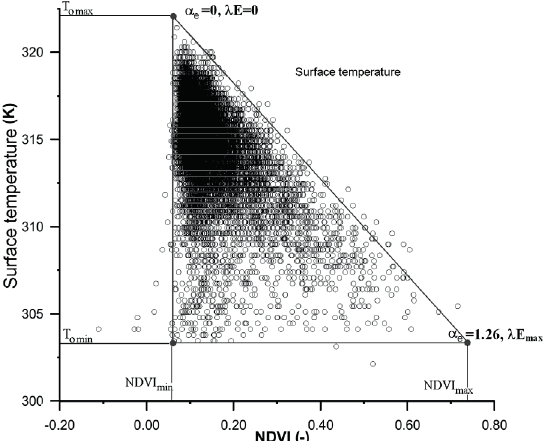
Fig. 2 Plot of surface temperature versus normalized difference vegetation index